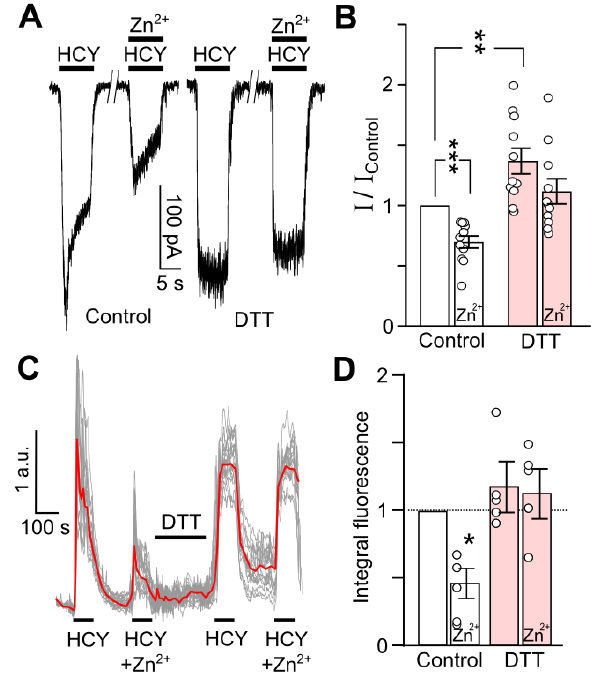
Figure 6. GluN2A-containing NMDAR contribution to HCY-activated currents and intracellular accumulation decreases after DTT treatment. ( A ) Representative traces of currents activated by 100